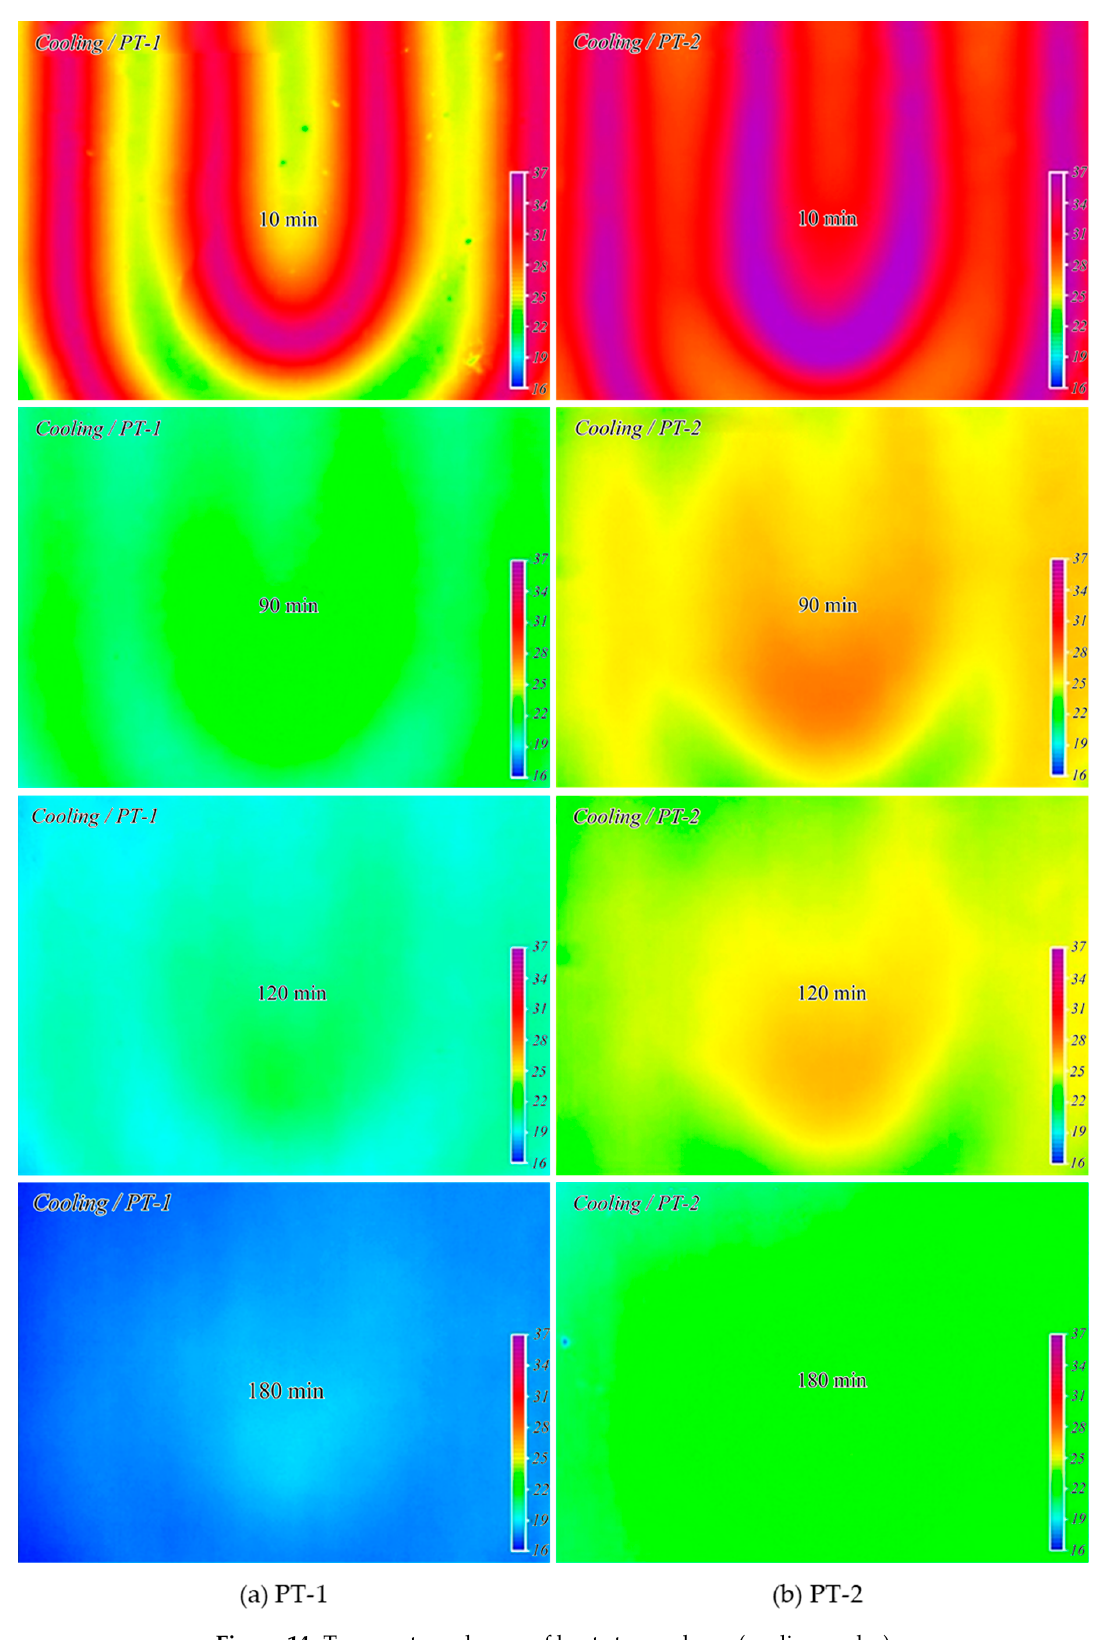
Figure 14. Temperature change of heat storage layer (cooling cycles).